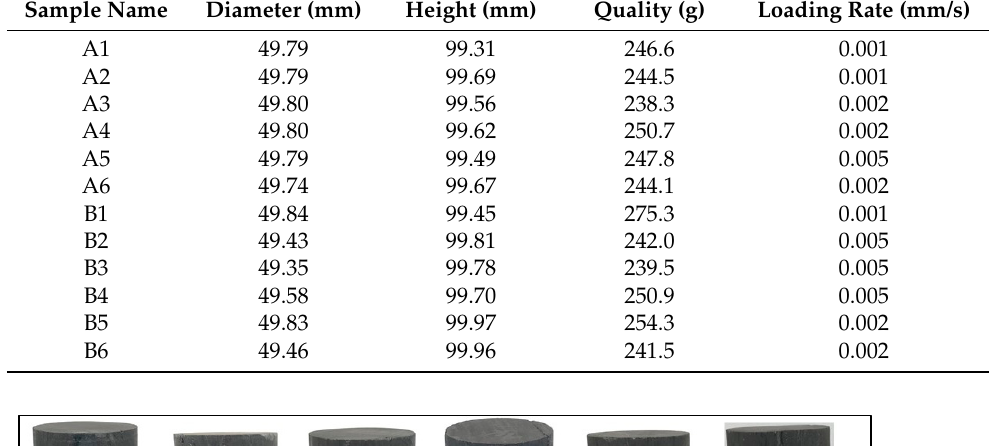
Table 1. Basic information on the bituminous coal samples.